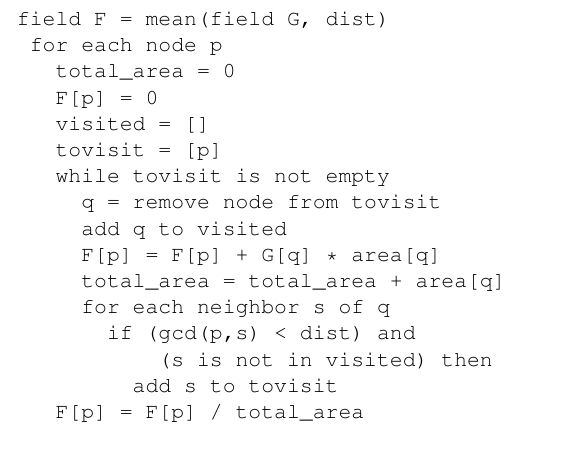
Algorithm 3 Given a field G defined on an unstructured grid and a set of candidate points P , remove candidate minima Algorithm 2 Locate the set of all nodes P that are local min- that are within a distance dist of a more extreme minimum, and return the new candidate set Q .